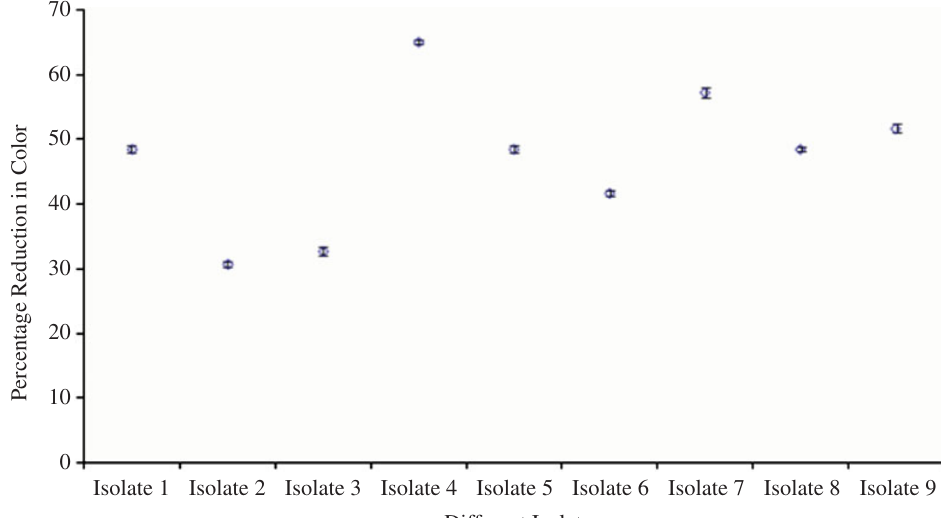
Fig. 2. Percentage reductions in color of pulp and paper mill effluent with different individual bacterial